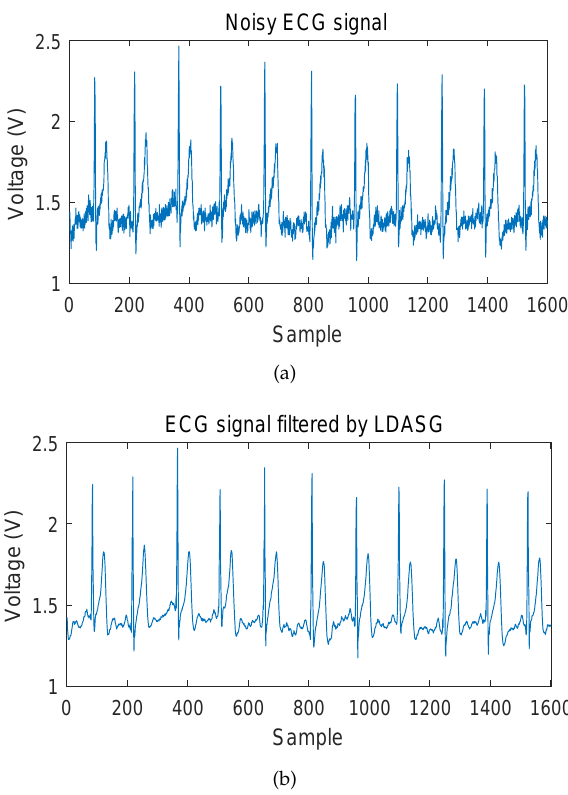
Figure 8. Result of denoising real wearable ECG signal by LDASG. ( a ) noisy ECG signal; ( b ) denoised ECG